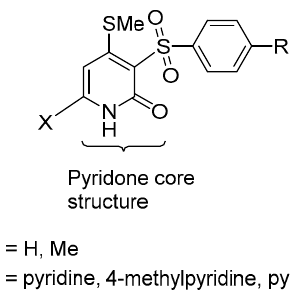
Figure 1. Schematic structure of novel fluorescence Zn 2+ sensors.